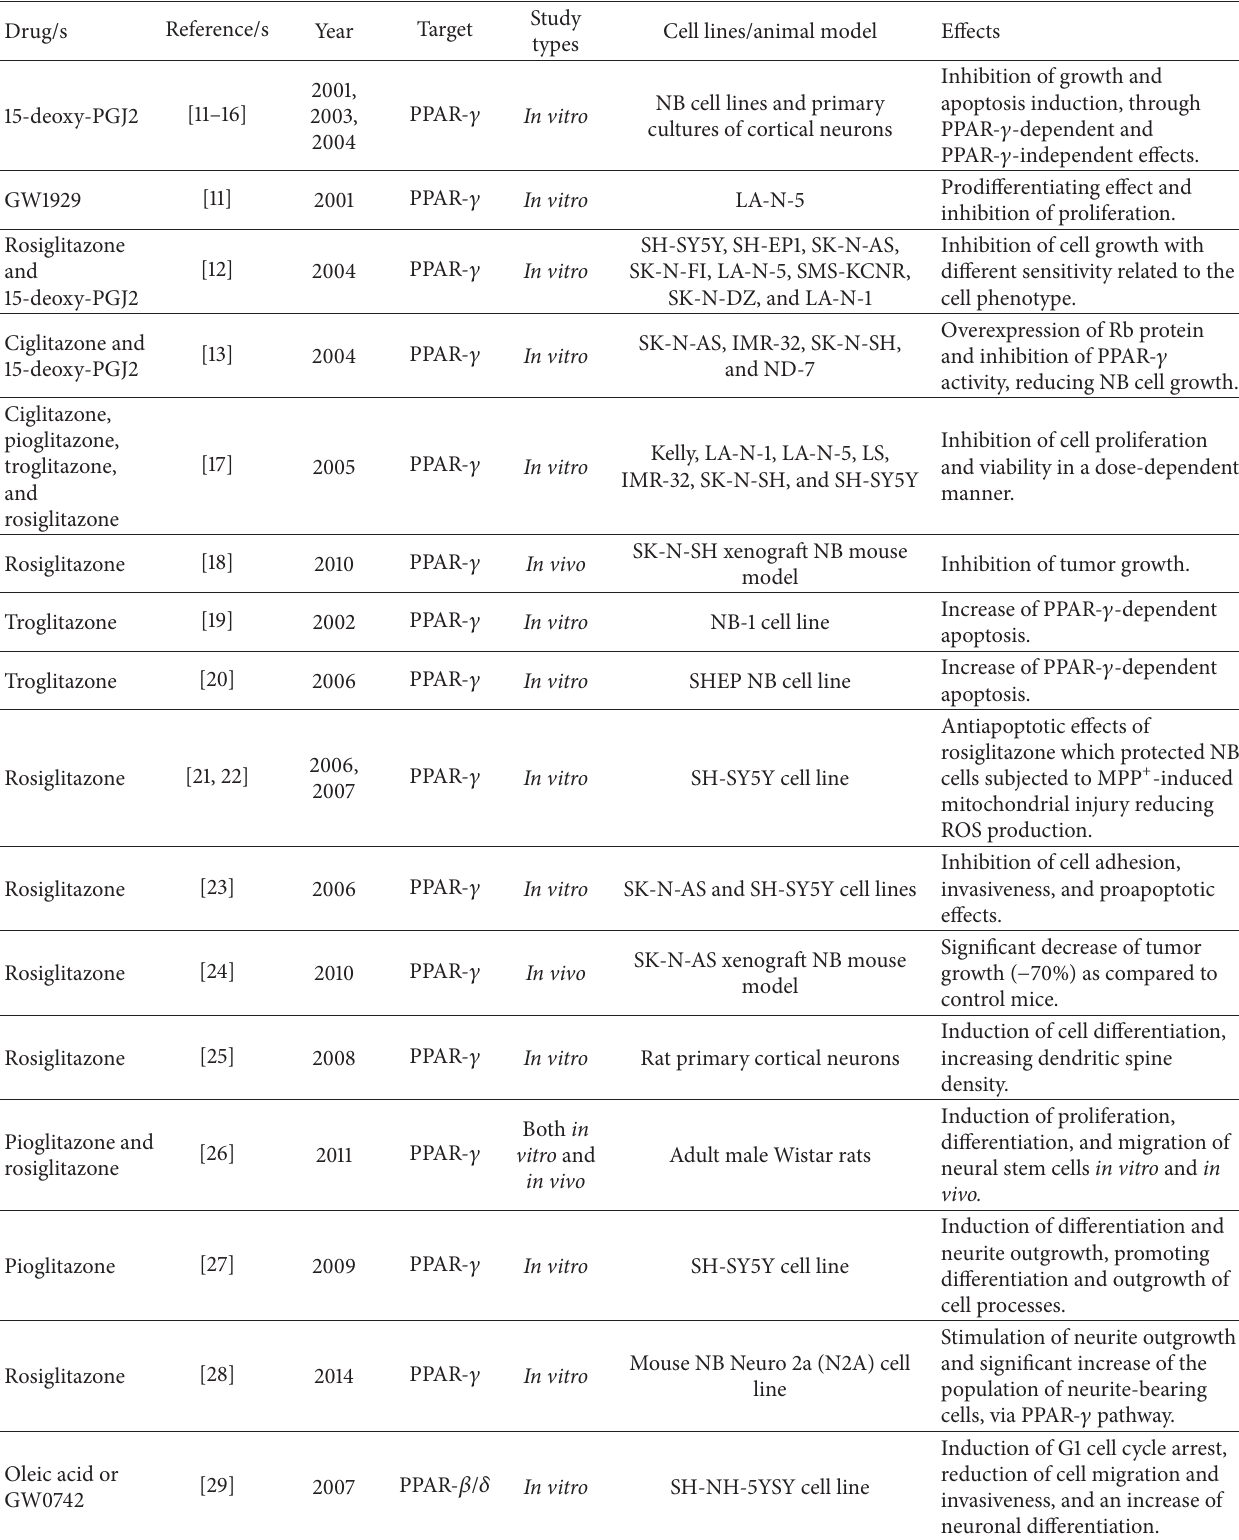
Table 1: Preclinical and experimental studies on PPAR agonists in